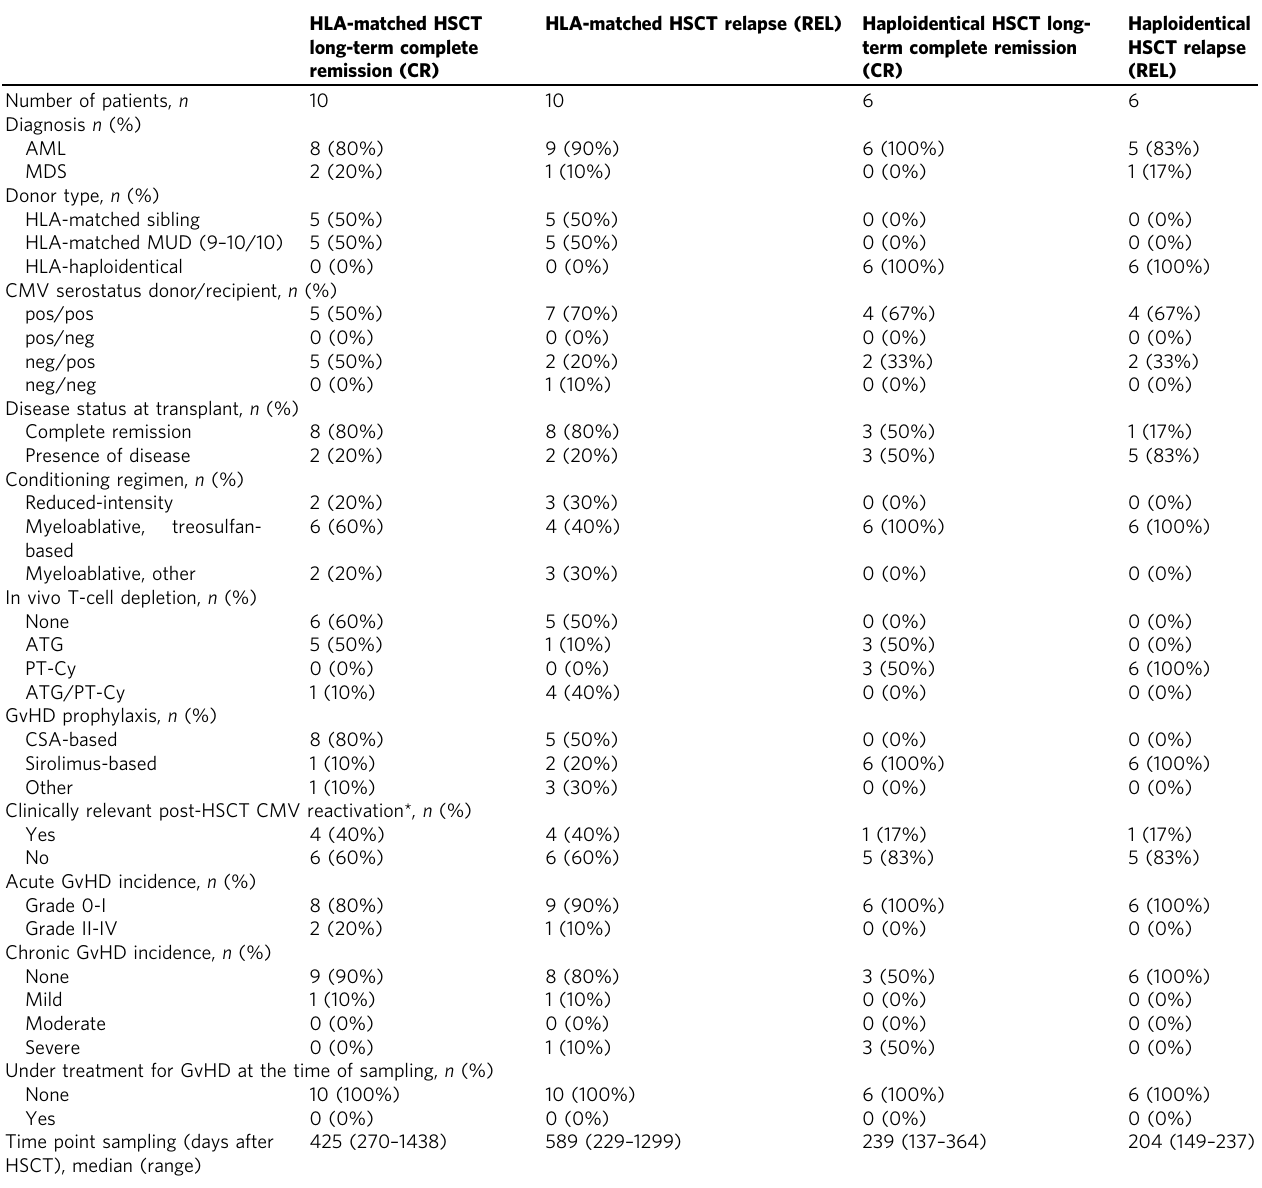
Table 1 Patients ’ characteristics at long-term follow-up